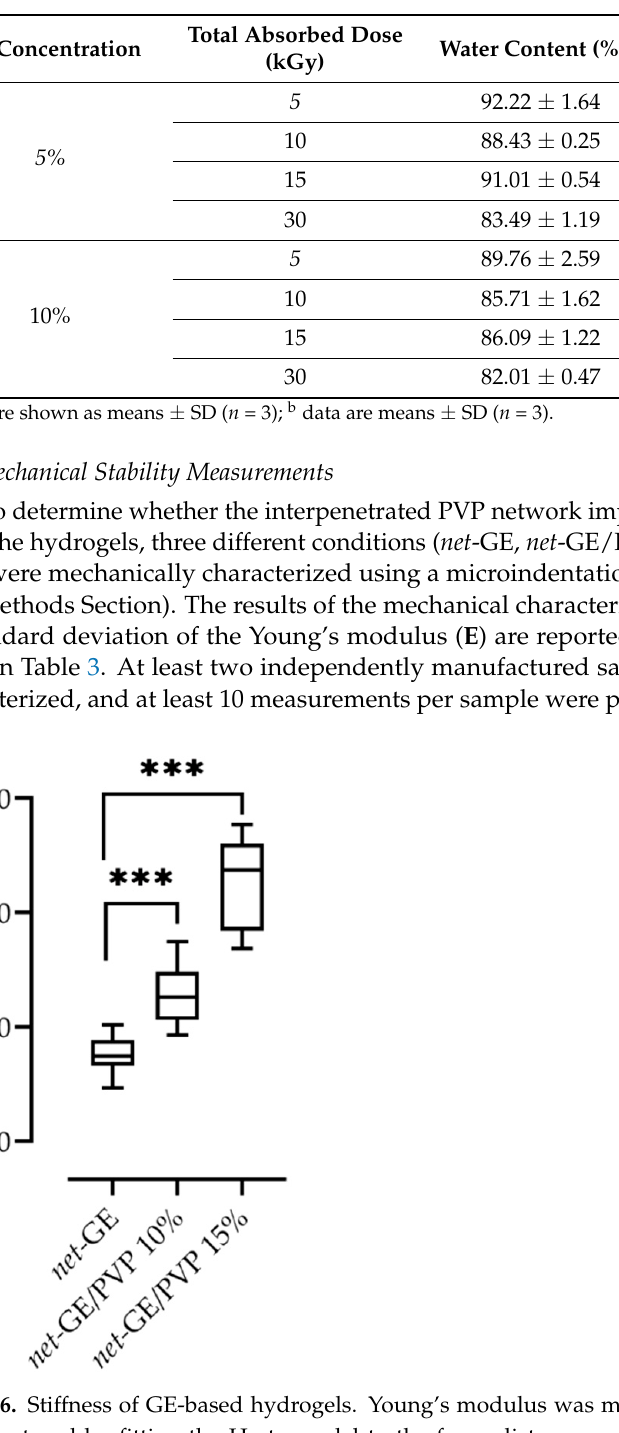
Table 2. Water content and equilibrium swelling of hydrogels of 5% and 10% GE with different total absorbed doses, expressed as percentages.